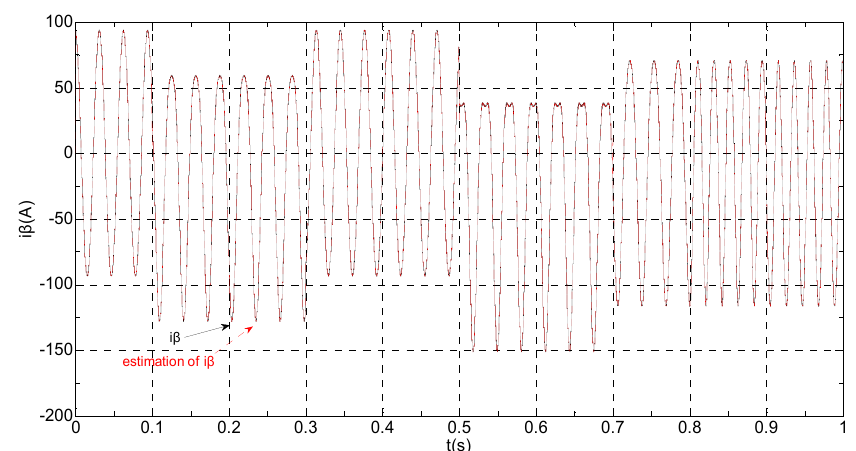
Figure 4. The actual and estimated value of i α .